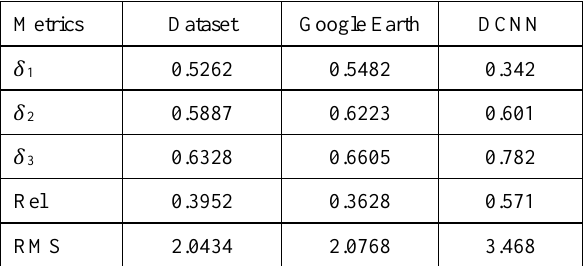
Table 2 . Evaluation metrics for depth